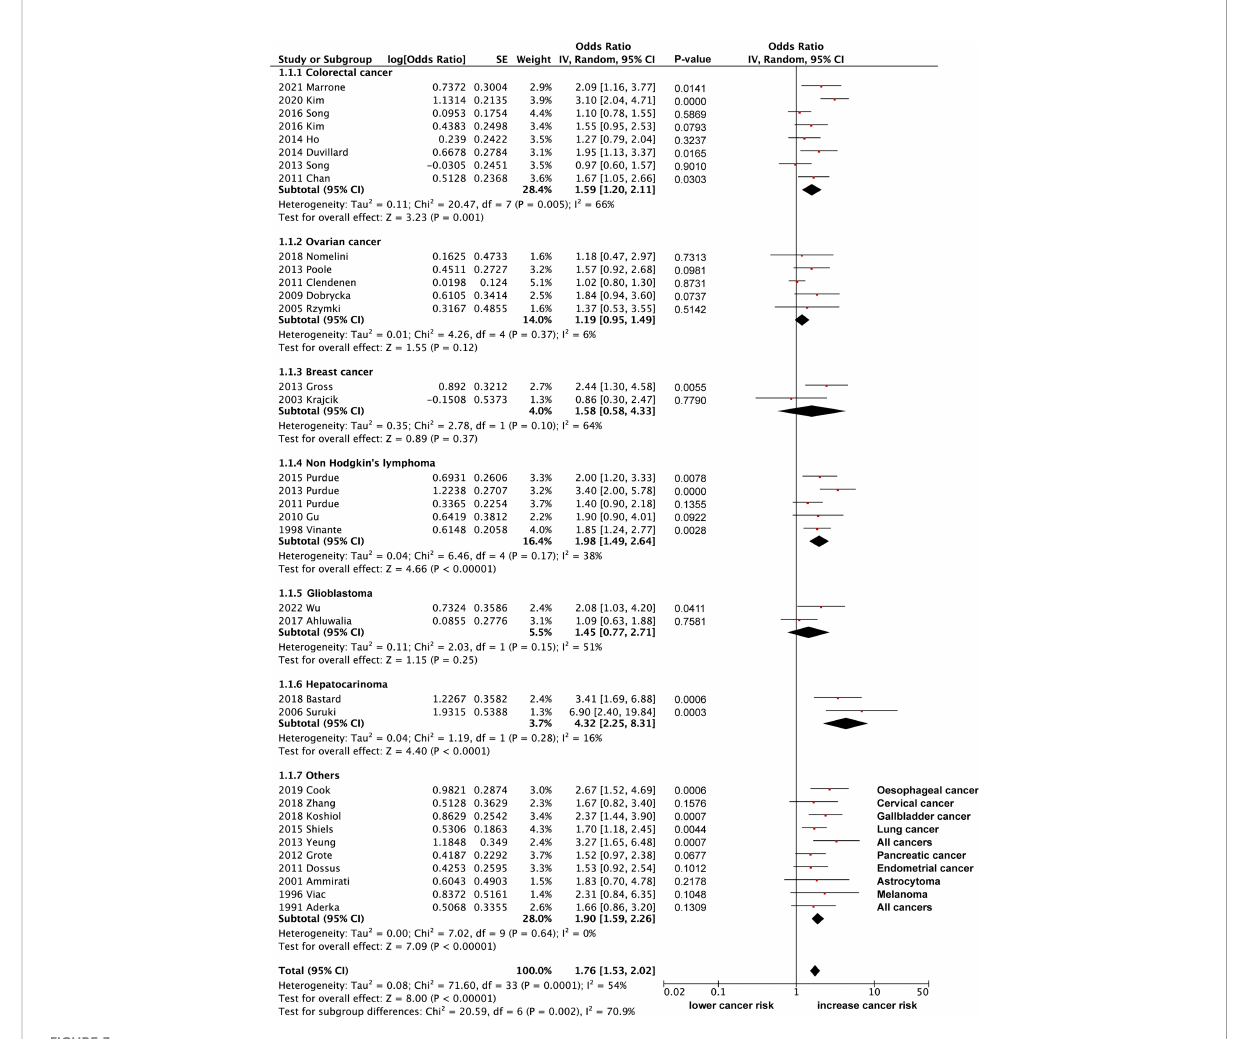
FIGURE 3 The forest plot showing overall OR of sTNFR2 and its correlation with cancer